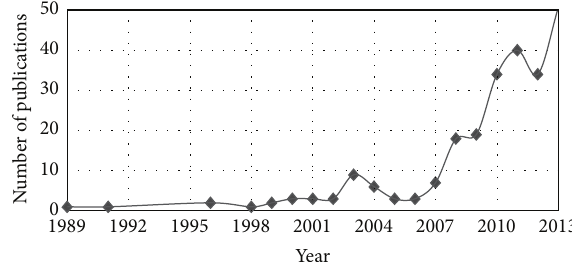
Figure 1: Number of studies related to butanol-diesel that were published between 1989 and 2013 (Scopus